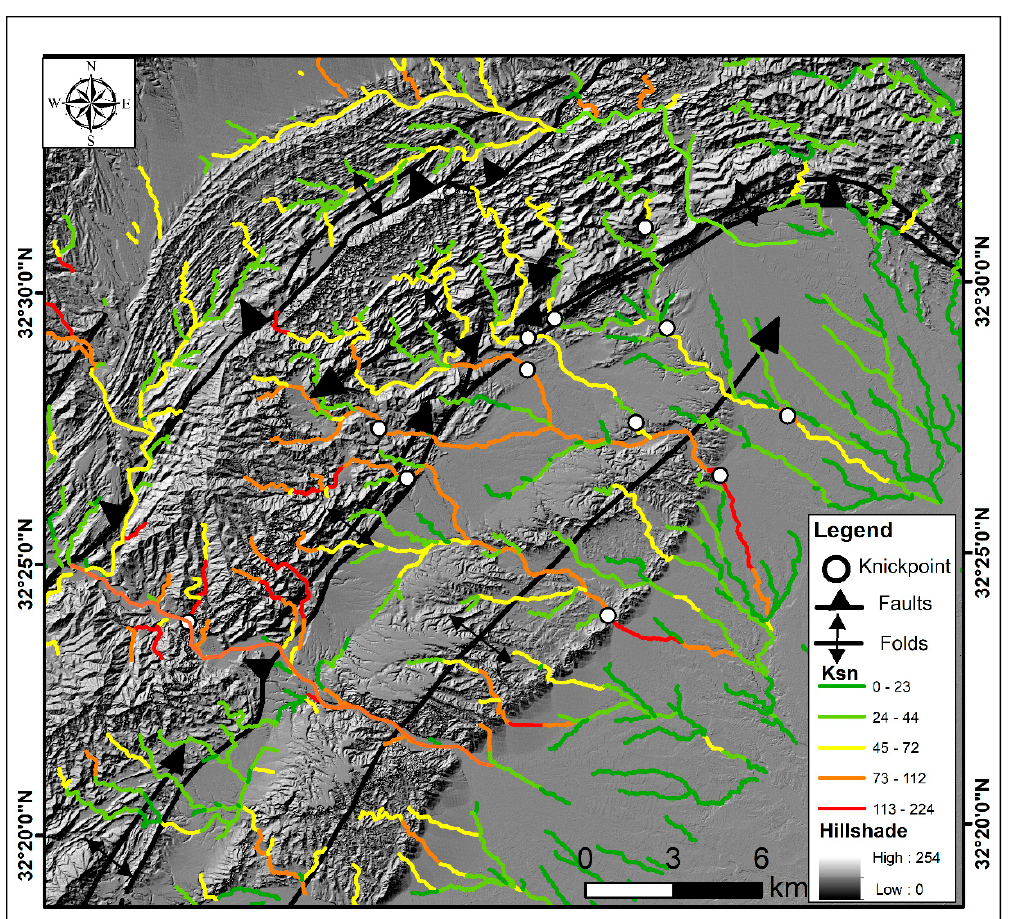
Figure 10. Shaded relief image showing the channel steepness index distribution and its association with the structural elements. The medium to high values were distributed both across the Khirgi anticline and the Manzai anticline. In contrast, the index value decreases along the Kundi anticline and may be related to low tectonic uplift. Knickpoints are plotted along the moderate to high Ksn segments values.